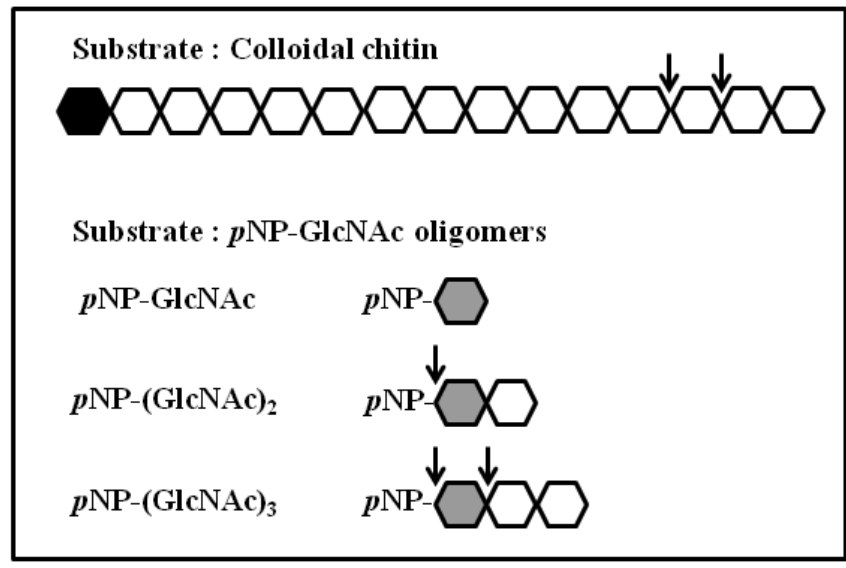
Figure 6. Schematic of the reaction catalyzed by chitinase 1198. Individual GlcNAc monomers are represented by hexagons. Black hexagons indicate the reducing ends of GlcNAc oligomers; gray hexagons indicate the reducing ends of pNP-GlcNAc oligomers. The arrows indicate cleavage sites in the experiments. 304 Table 2. Hydrolytic activity of chitinase 1198 on pNP-(GlcNAc) 1–3 . 305 Substrate Table 3. Comparison of kinetic parameters of different chitinase 1198 constructs on pNP-(GlcNAc) 2 . 307